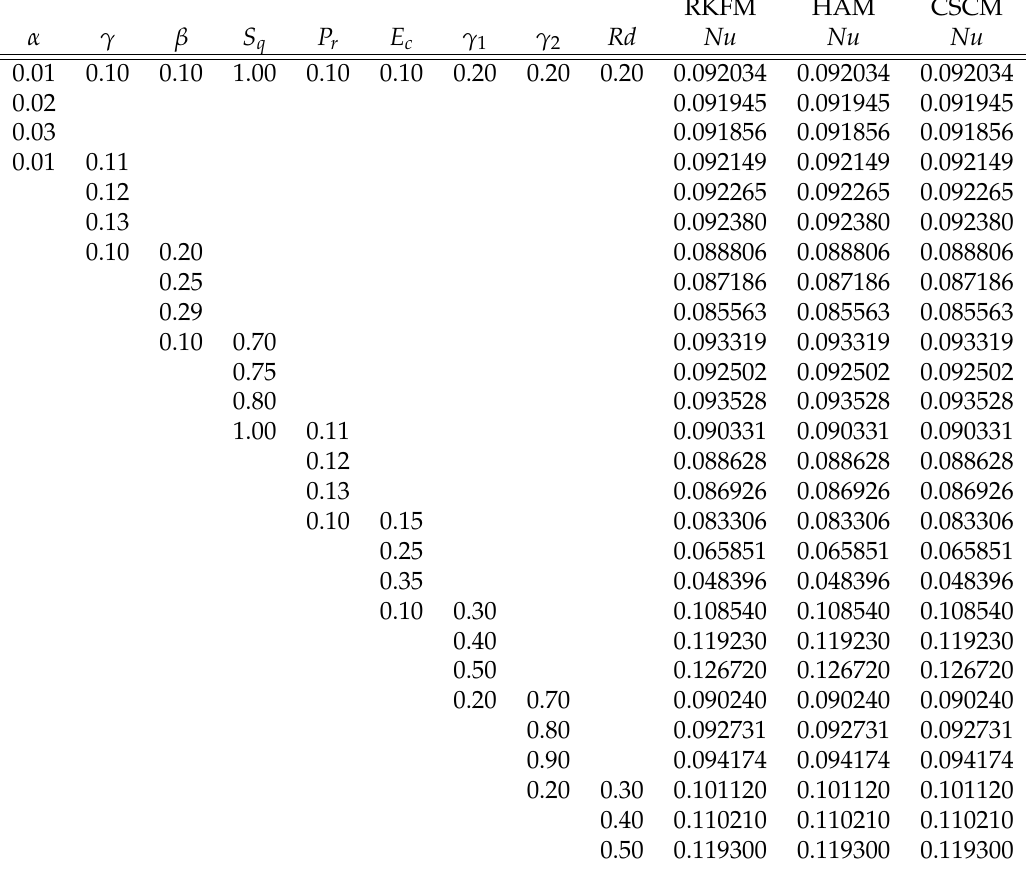
Table 2. Numerical values of Nusselt number for different